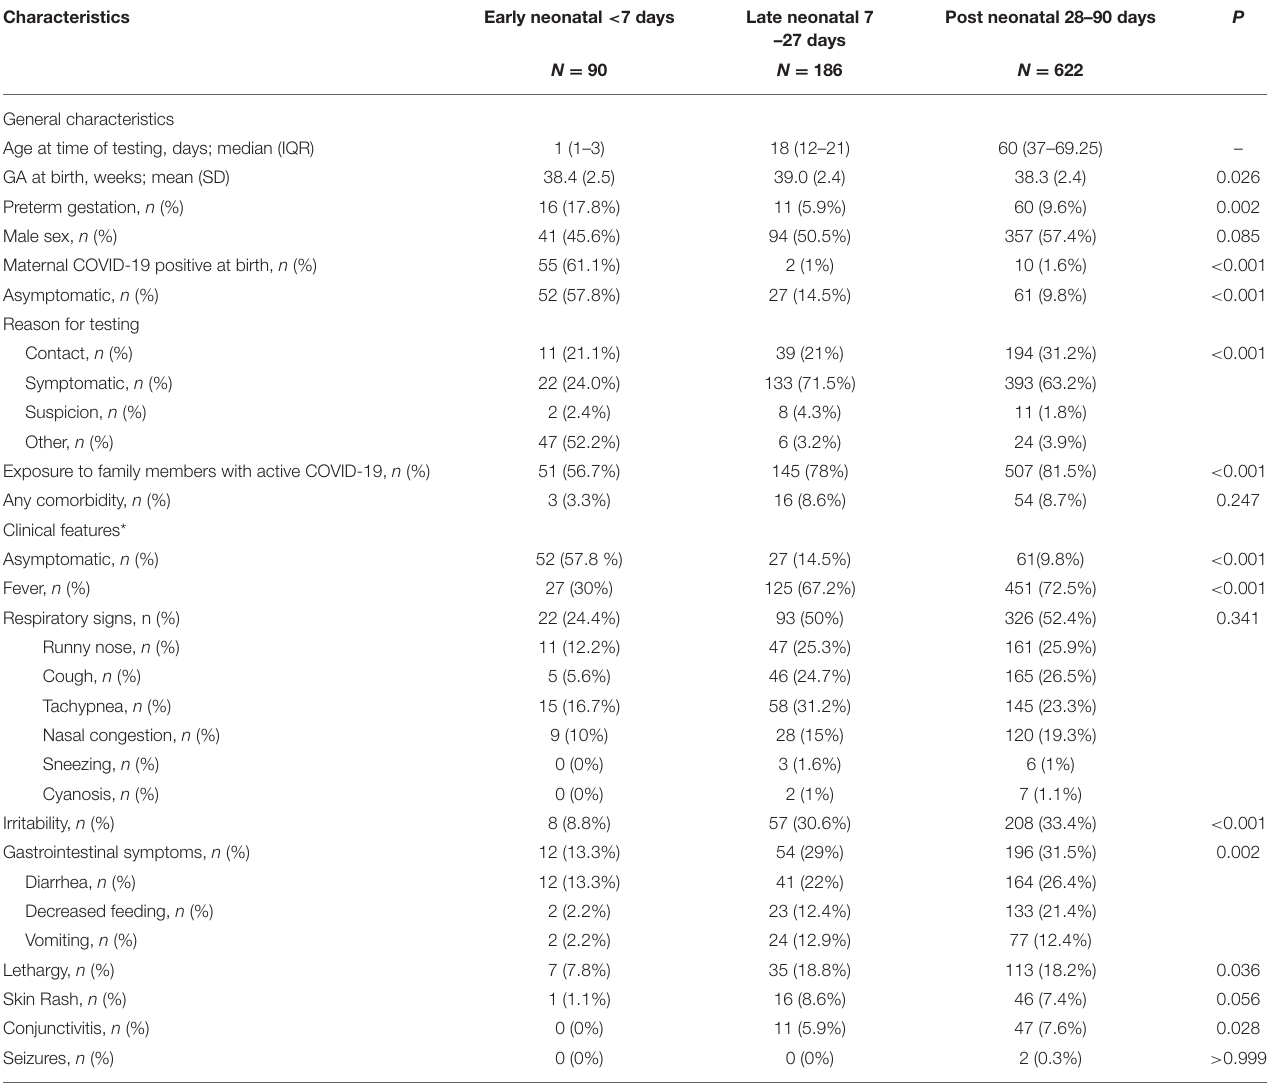
TABLE 1 | Characteristics of study